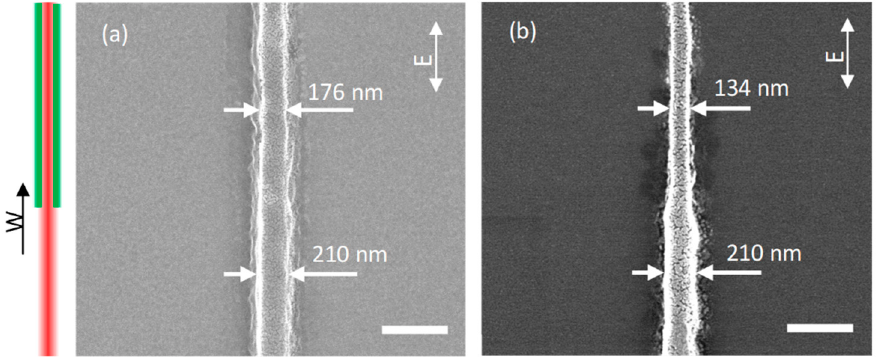
Figure 3. Scanning electron micrograph of nanowires written in PETA with two different photoinitiators, ( a ) 0.5 wt% ITX in PETA and ( b ) 0.5 wt% DETC in PETA. W: scanning direction, E: laser polarization direction, scale bar 400 nm.